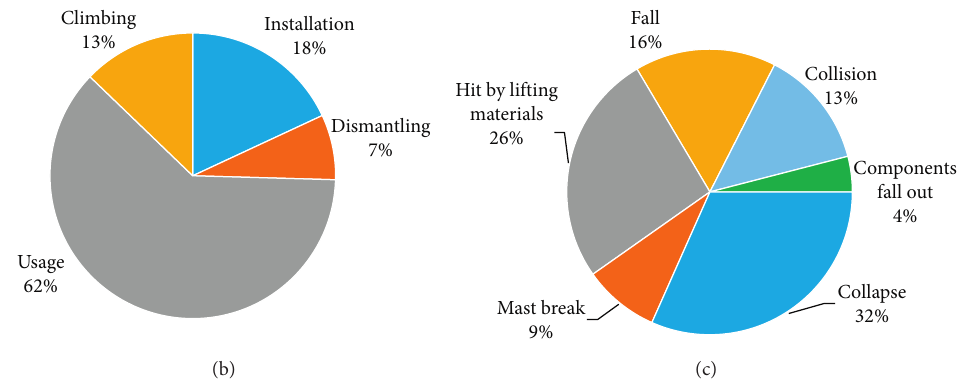
Figure 8: Information of accident reports: (a) Accident consequence; (b) Accident phase; (c) Accident type. Table 3: Casualties of tower crane accidents.